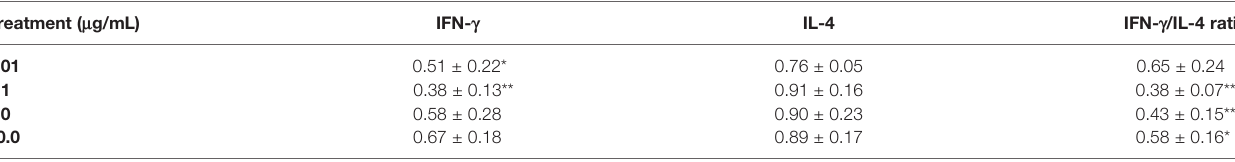
TABLE 1 | Effect of G on PHA-induced cytokine production. Treatment ( m